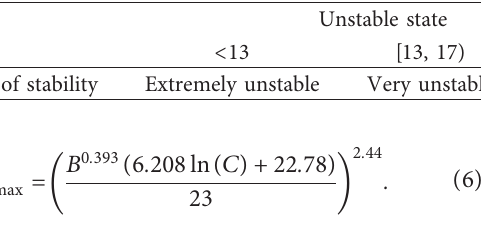
Table 10: Index value and qualitative description of tunnel